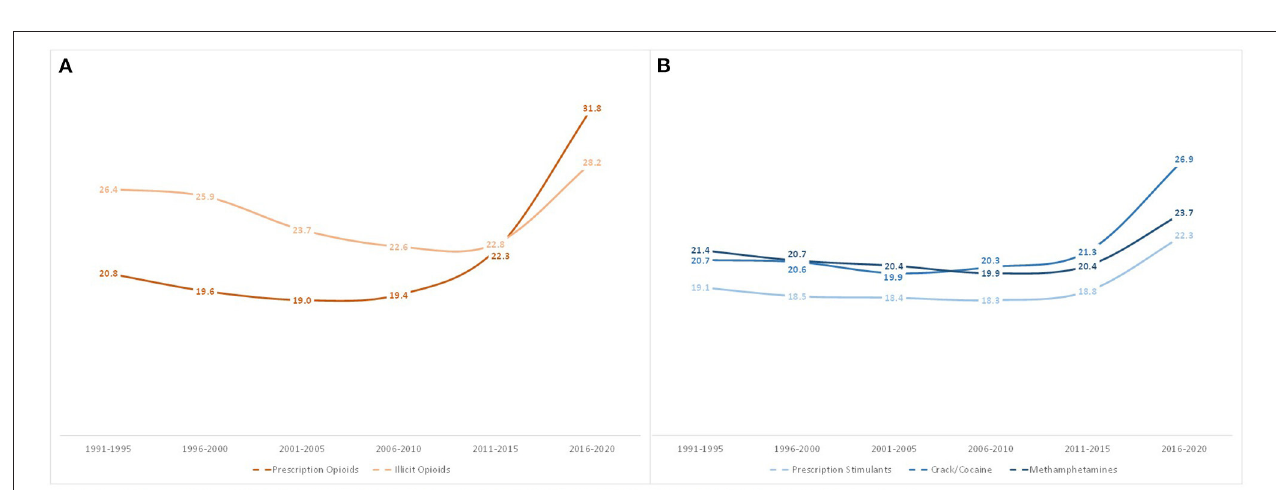
FIGURE 3 | Mean age of first use of opioids (A) and stimulants (B) among individuals with opioid use disorder by year of drug